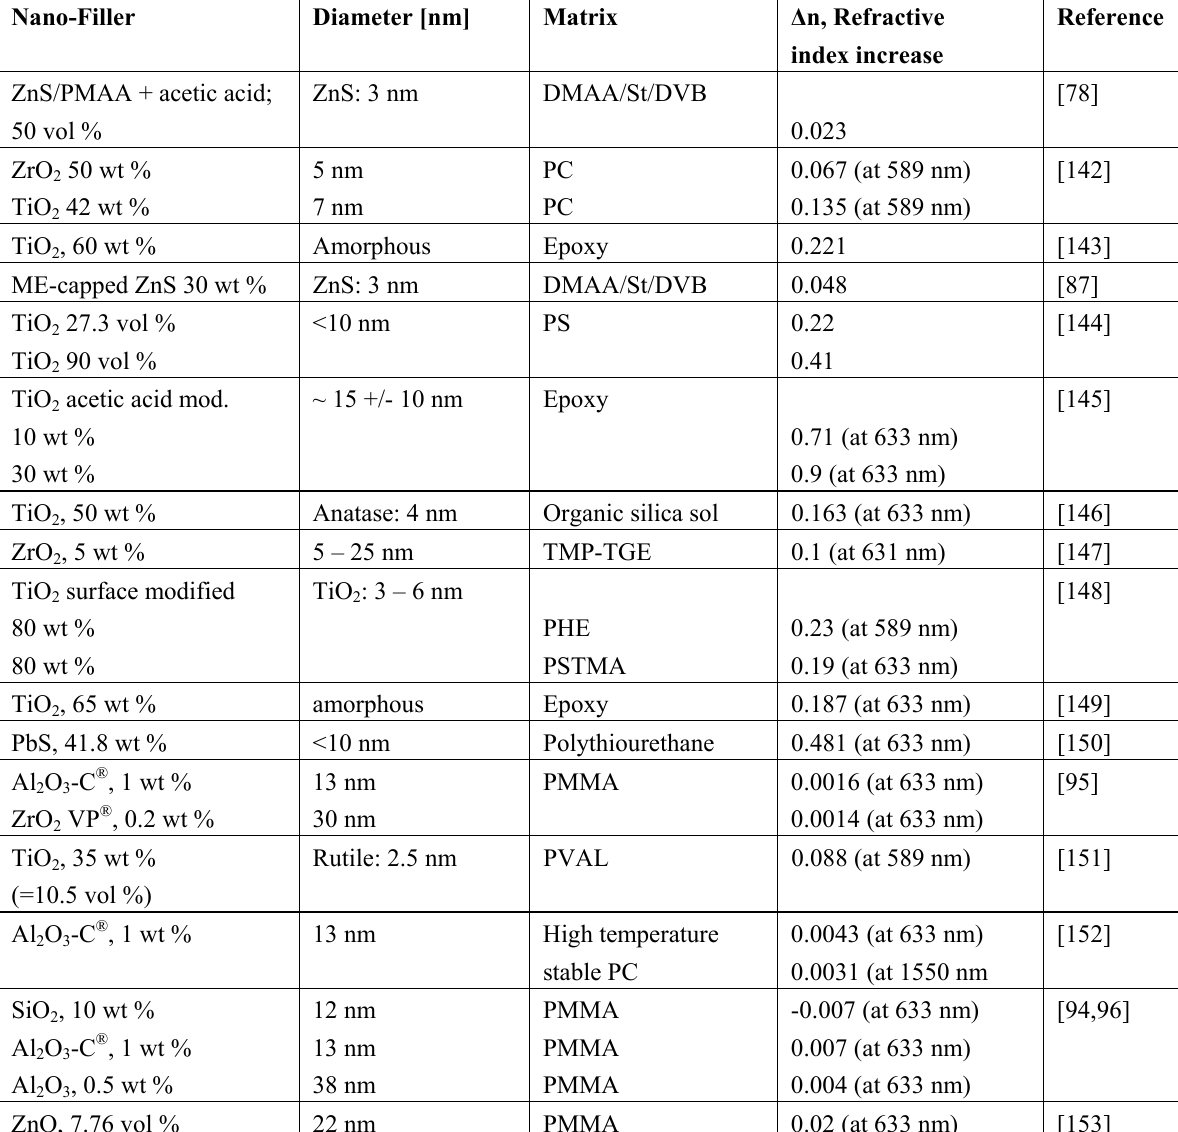
Table 5. Modification of refractive indices in particle/matrix nanocomposites.